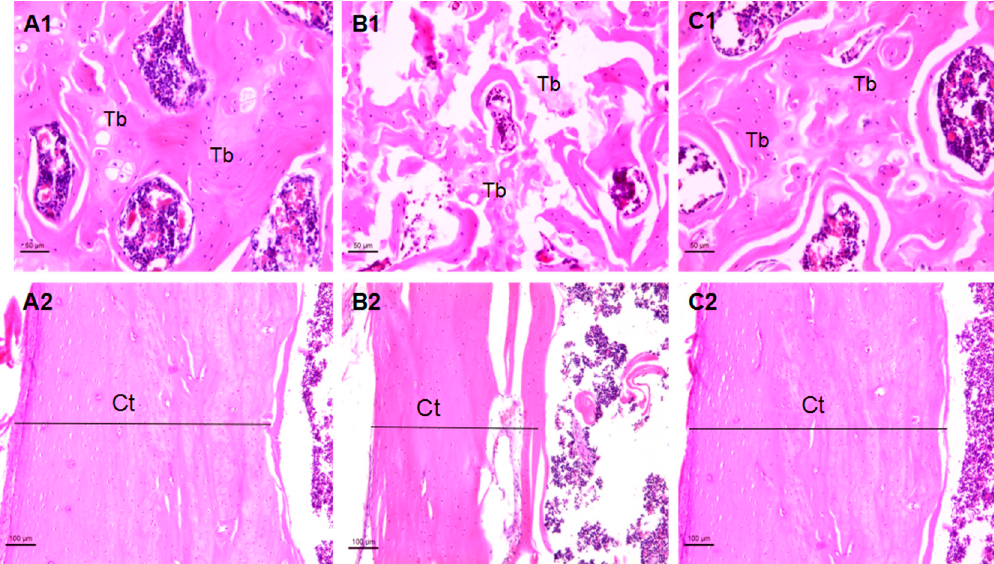
Figure 3. The femoral and tibia morphology of rats in each group. ( A1 ) The femur metaphysis in a rat of control group; ( B1 ) the femur metaphysis in a rat of T1DM (diabetic) group; ( C1 ) the femur metaphysis in a rat of the T1DM-icariin (ICA) group; ( A2 ) the tibia in a rat of control group; ( B2 ) the tibia in a rat of T1DM group; ( C2 ) the tibia in a rat of the T1DM-ICA group. Hematoxylin and eosin staining, magnification: 200× Tb: Trabecular bone. Ct: Cortical bone.